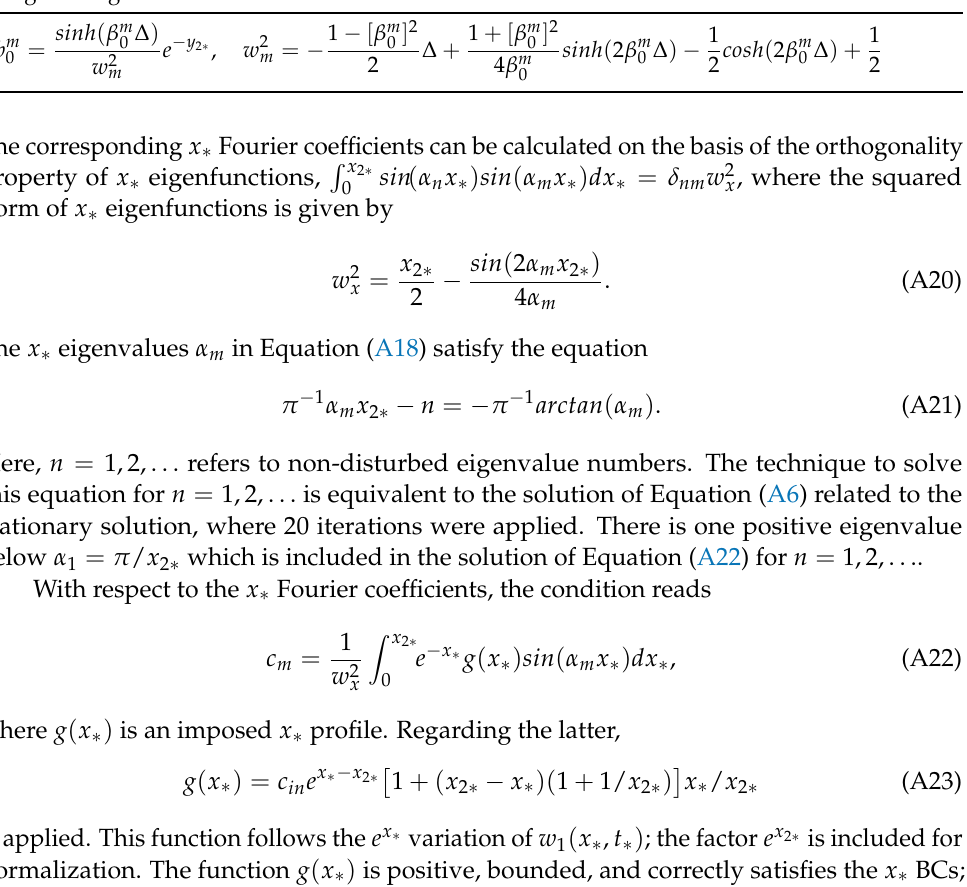
Table A2. y ∗ Fourier coefficients b n and b m Positive